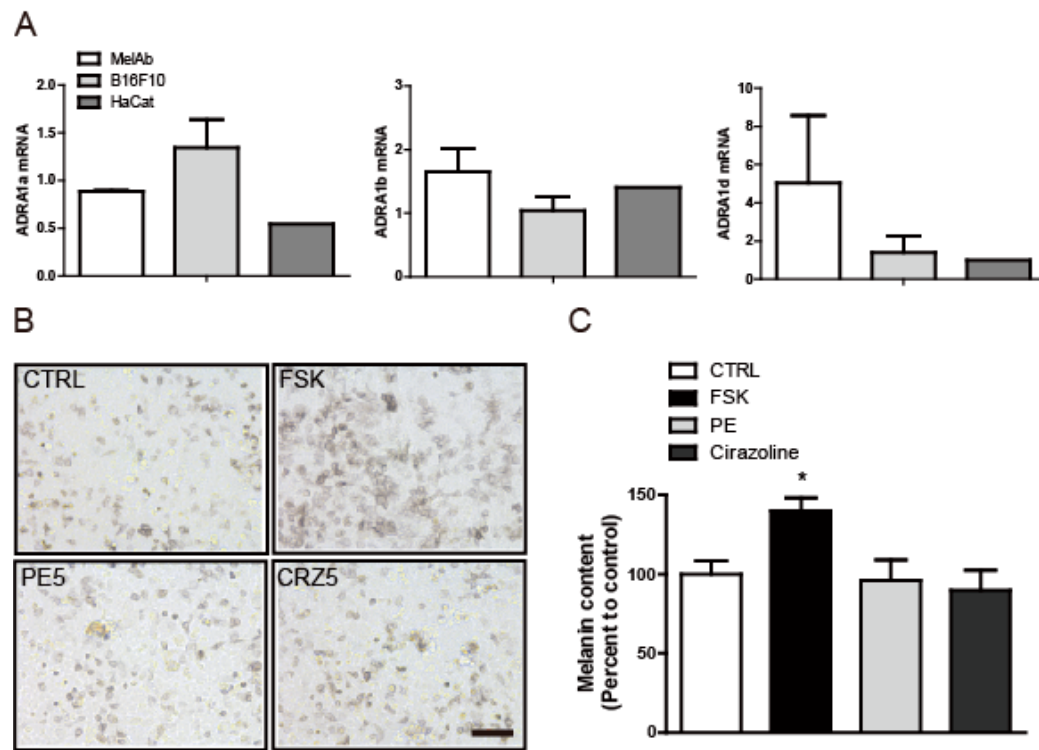
Figure 4. Suppression of melanin production by L-765,314 did not involve the adrenoceptor signaling pathway. ( A ) Expression of ADRA1a, ADRA1b, and ADRA1d in Mel-ab, B16F10, and HaCat cells was